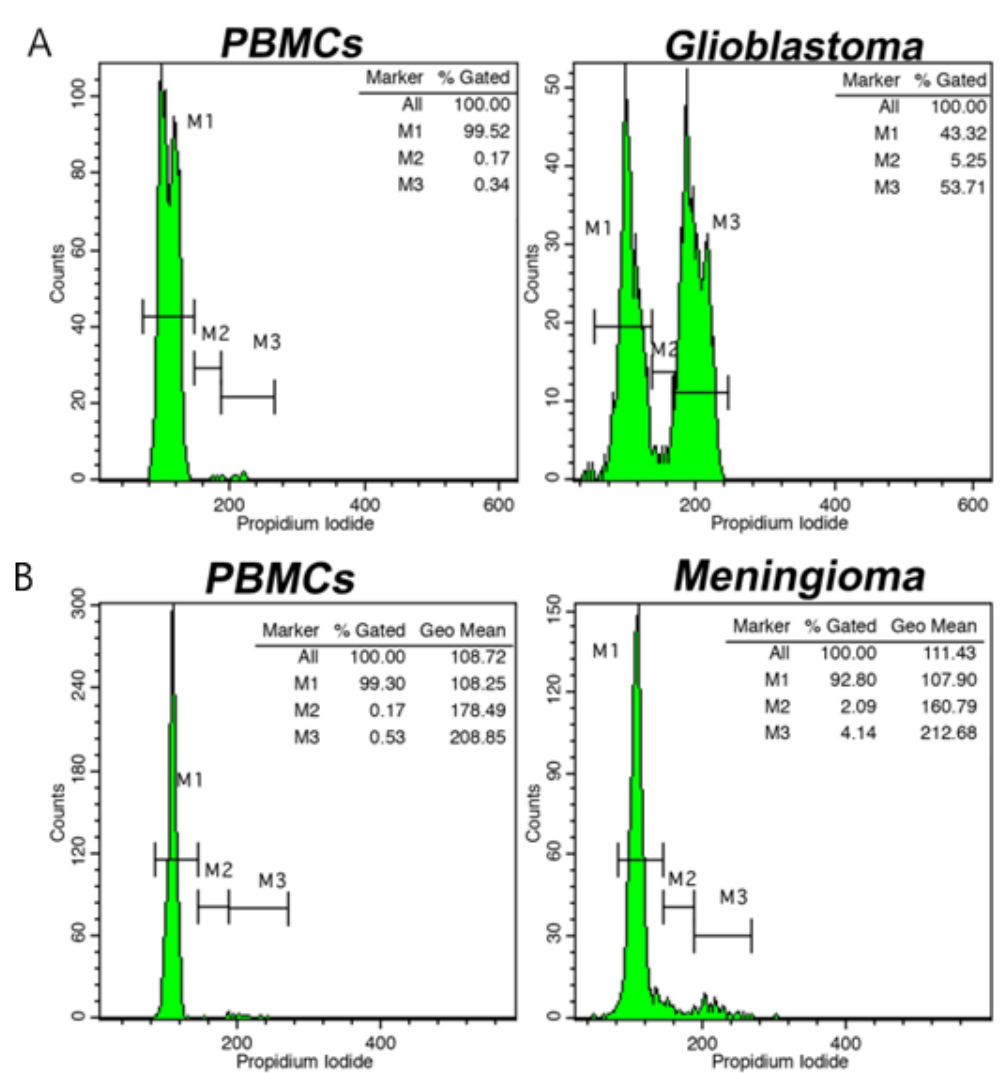
Figure 3. ( A ). Cell-cycle distribution analysis using intraoperative flow cytometry (iFC) in a glioblastoma case ( A ) and in a meningioma case ( B ). Markers M1, M2, and M3 represent G0/G1, S, and G2/M cell-cycle phases, respectively. On the left of each figure, the cell-cycle distribution of peripheral blood mononuclear cells (PBMCs) is presented as control. Tumor index is quantified in each case as the sum of cells from M2 and M3 markers, indicative of proliferating tumor cells. In addition, DNA index (DI) is calculated as the ratio of the geometric mean of cancer cells in M1 (G0/G1 phase) to that of normal cells, in our case, PBMCs. A DI = 1.0 indicates diploid cells; a DI > 1.1, hyperploidy; whereas a DI < 0.9,